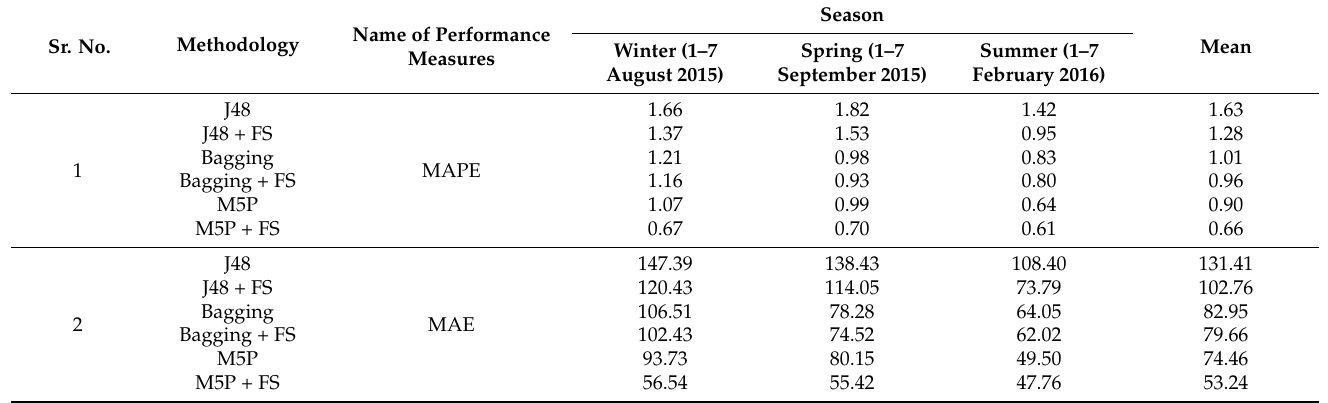
Table 5. Performance of proposed methodology in terms of various performance measures.